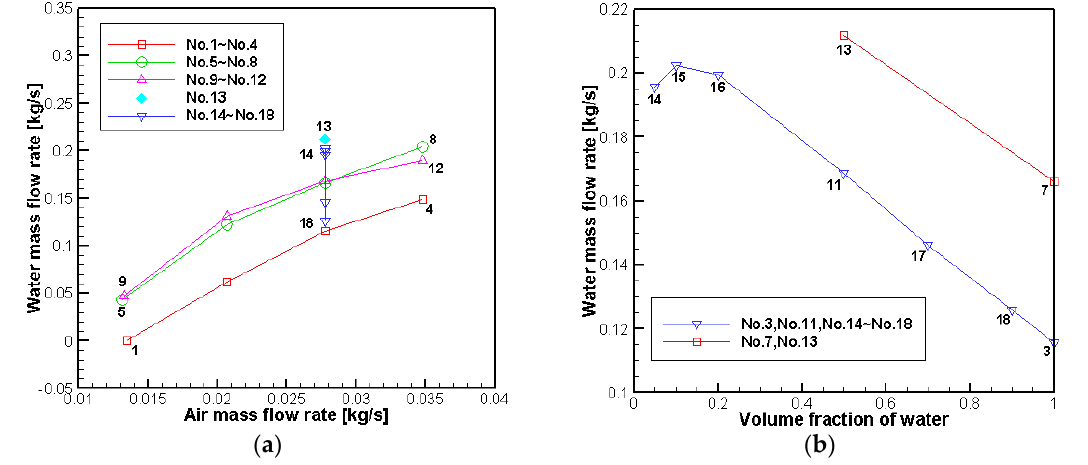
Figure 9. Comparison of mass flow rates of hybrid airlift-jet pump in various operating conditions: ( a ) all cases; ( b ) airlift-jet hybrid pump cases.